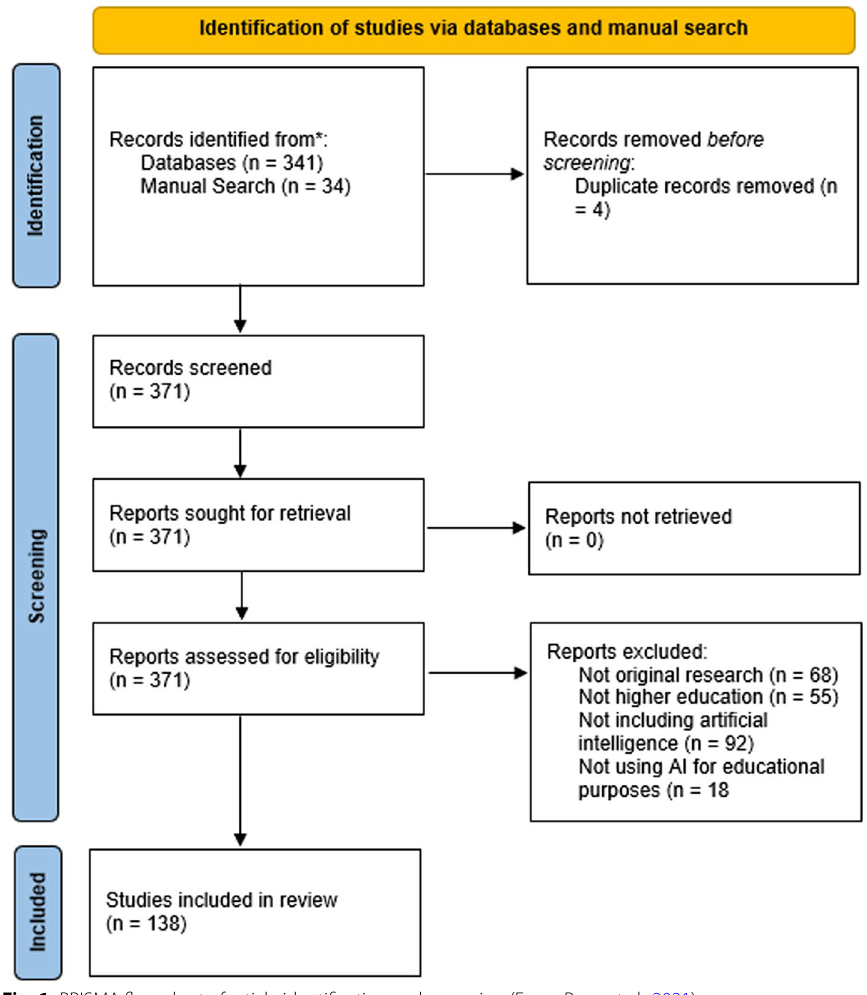
Fig. 1 PRISMA flow chart of article identification and screening (From: Page et al.,